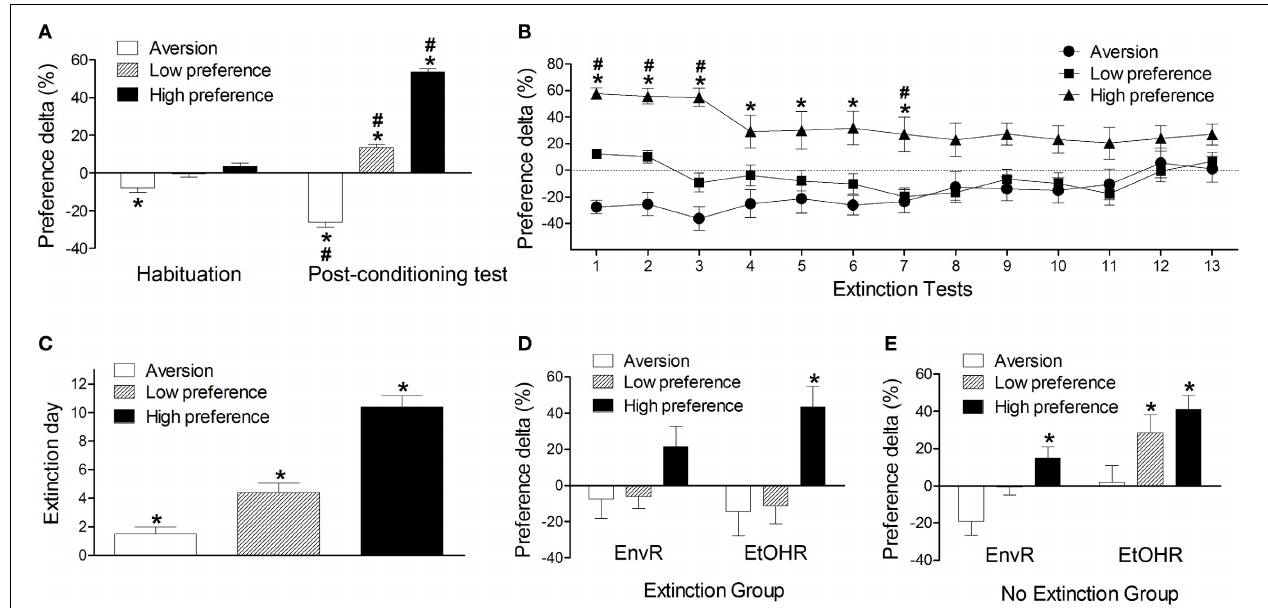
FIGURE 2 | (A) Preference delta for the CS + compartment (mean ± s.e.m) of mice conditioned with 2.2g/kg ethanol from Experiments 1–3A in the habituation and post-conditioning test classified as aversion ( n = 32), low preference ( n = 57) or high preference ( n = 65) according to the classification model based on the preference delta. ∗ Differs from the other groups in the same test. #Differs from the habituation test ( P < 0 . 001). (B) Preference delta for the CS + compartment in the extinction tests phase of ethanol-conditioned mice (Experiment 2 extinction protocol) classified as aversion ( n = 12), low preference ( n = 20) and high preference ( n = 15). ∗ Differs from the aversion group in the same test ( P < 0. 05). #Differs from the low preference group in the same test ( P < 0. 05). (C) Number of days required for the conditioned behavior to be extinguished (mean ± s.e.m) of ethanol-conditioned mice